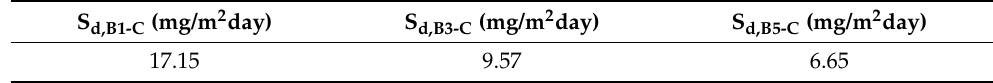
Table 27. Weighted arithmetic means of measuring by wet candle method for location B1, B3 and